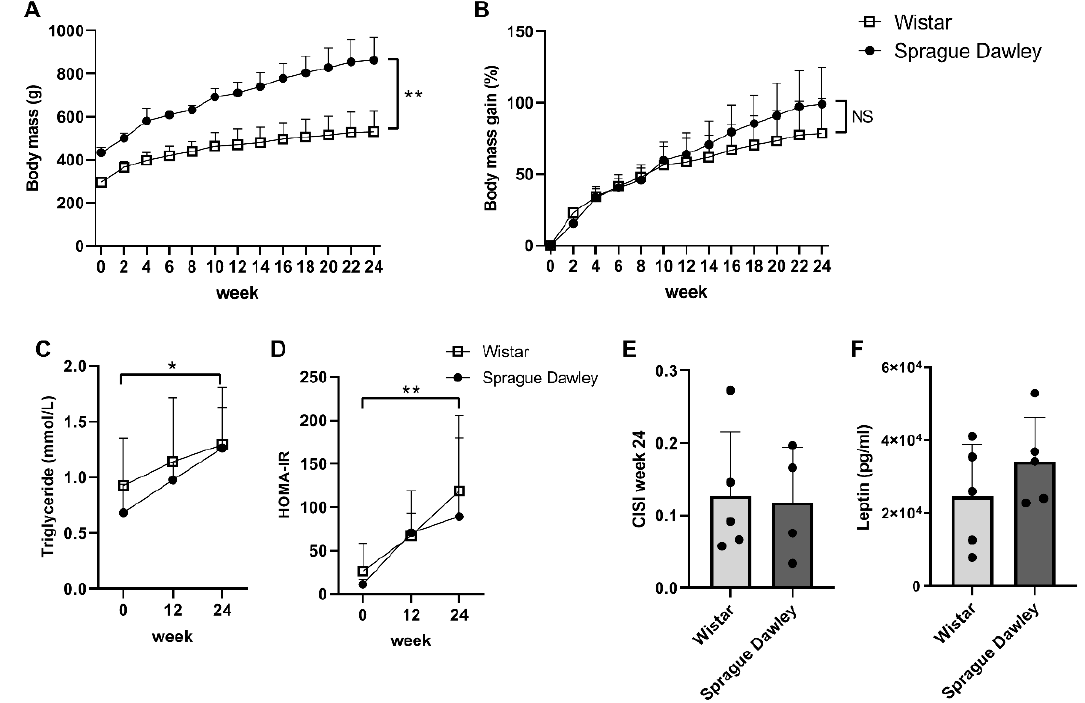
Figure 1. Body mass and metabolic parameters. ( A ) Total body mass over 24 weeks, asterisks indicate p < 0.01 at every time point and ( B ) gain in body mass as a percentage of baseline body mass, NS indicates p > 0.05 at every time point. ( C ) Plasma triglyceride measurements and ( D ) HOMA-IR determined from fasting glucose and insulin concentrations at weeks 0, 12 and 24. ( E ) CISI score determined from glucose tolerance test and ( F ) serum leptin concentration at week 24. p ≤ 0.05 is *, p ≤ 0.01 is ** and p > 0.05 is not significant (NS).